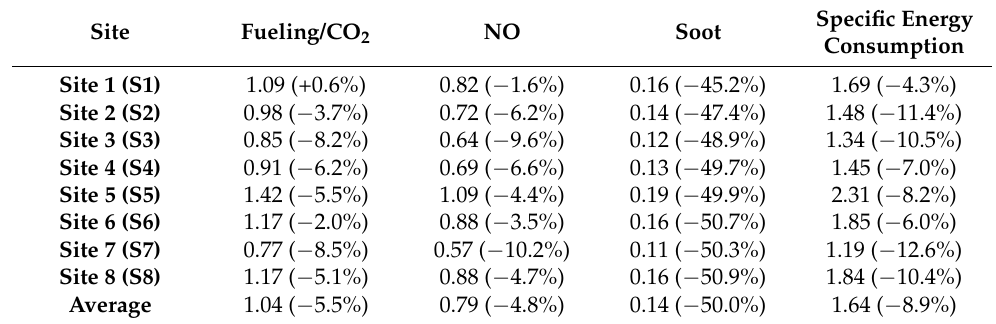
Table 7. Cycle-averaged drag coefficient method result (all values correspond to rise % over the reference